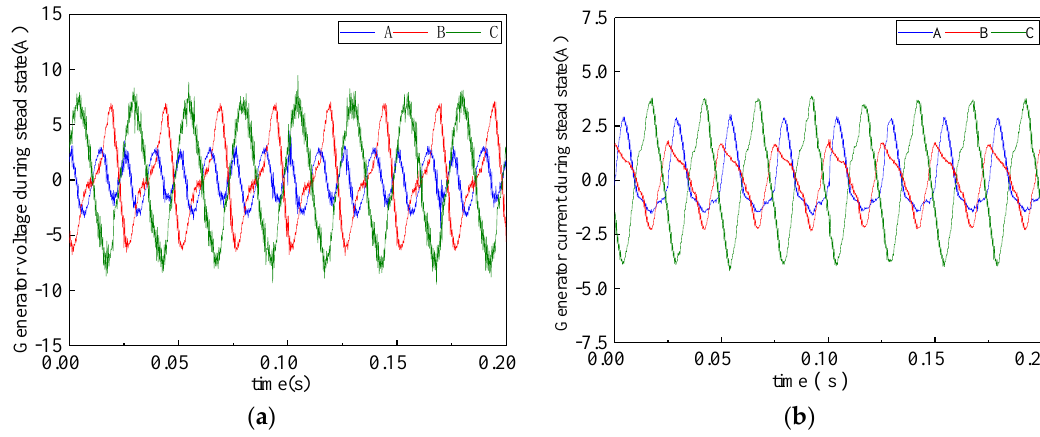
Figure 17. Generator voltage waveforms and current waveforms during steady state generating test: ( a ) generator voltage waveforms; and ( b ) generator current waveforms.